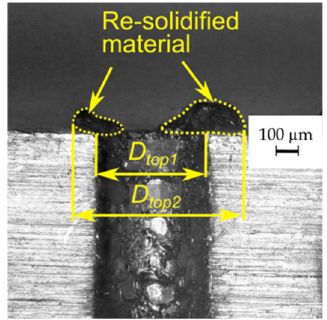
Figure 13. Image of the through hole top of one part of the sample after separation.